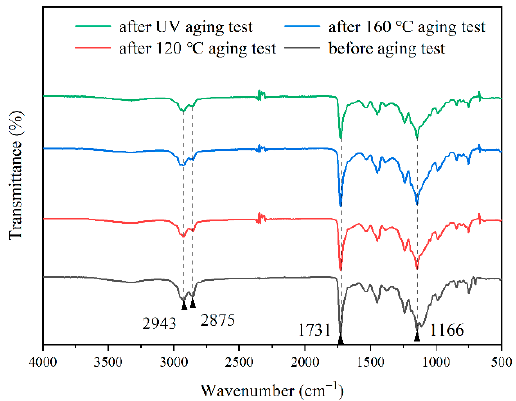
Figure 15. Infrared spectrogram of coating without microcapsules before and after aging.